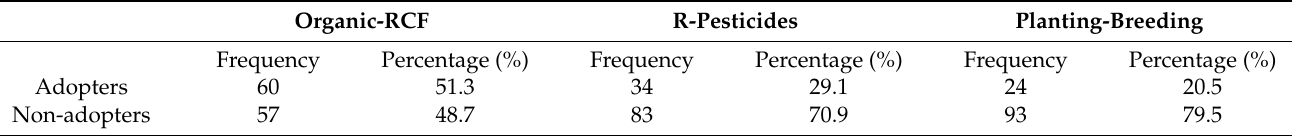
Table 3. Family farms’ adoption of CLPQIT ( n = 117).